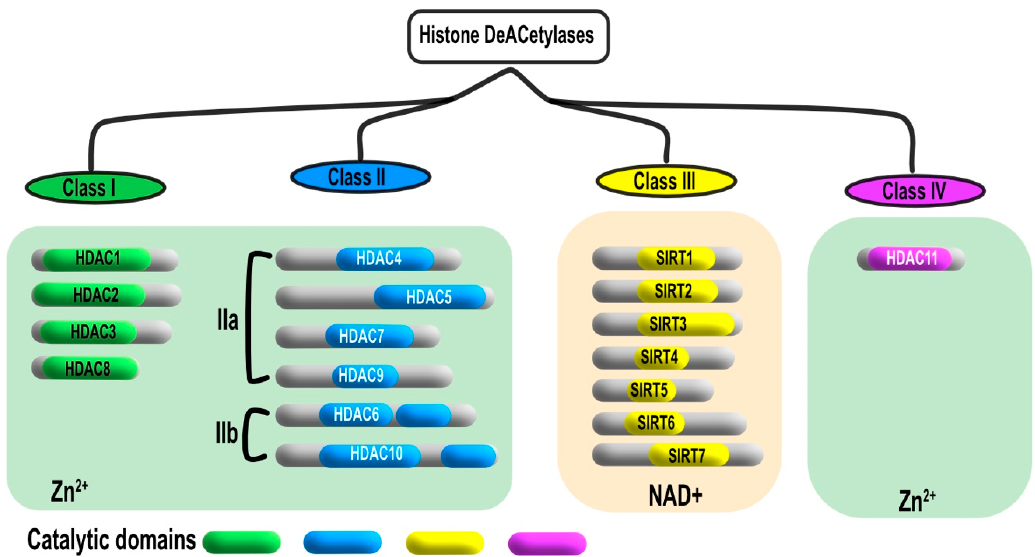
Figure 2. Different classes of HDACs. Four different classes of HDACs were identified in mammalian cell based on their sequence homology and structure similarity to the corresponding yeast HDACs. Class I is homologous to the yeast reduced potassium dependency 3 (RPD3) and includes HDAC1, 2, 3, 8. Class II is homologous to yeast Hda1 and divided into two sub classes, class IIa HDAC4, 5, 7, 9